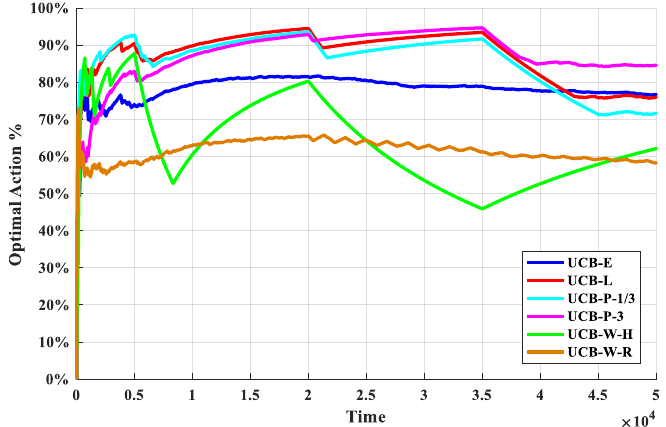
Figure 5. The cumulative regret for the O-D-UCB policies with different discount functions in dataset b.